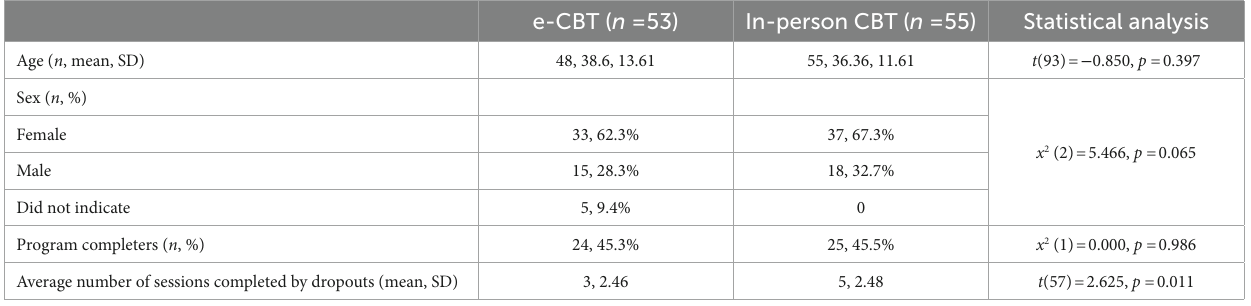
TABLE 1 Demographics and characteristics of the sample, separated by treatment group, electronic cognitive behavioral therapy (eCBT) and in-person CBT (cognitive behavioral